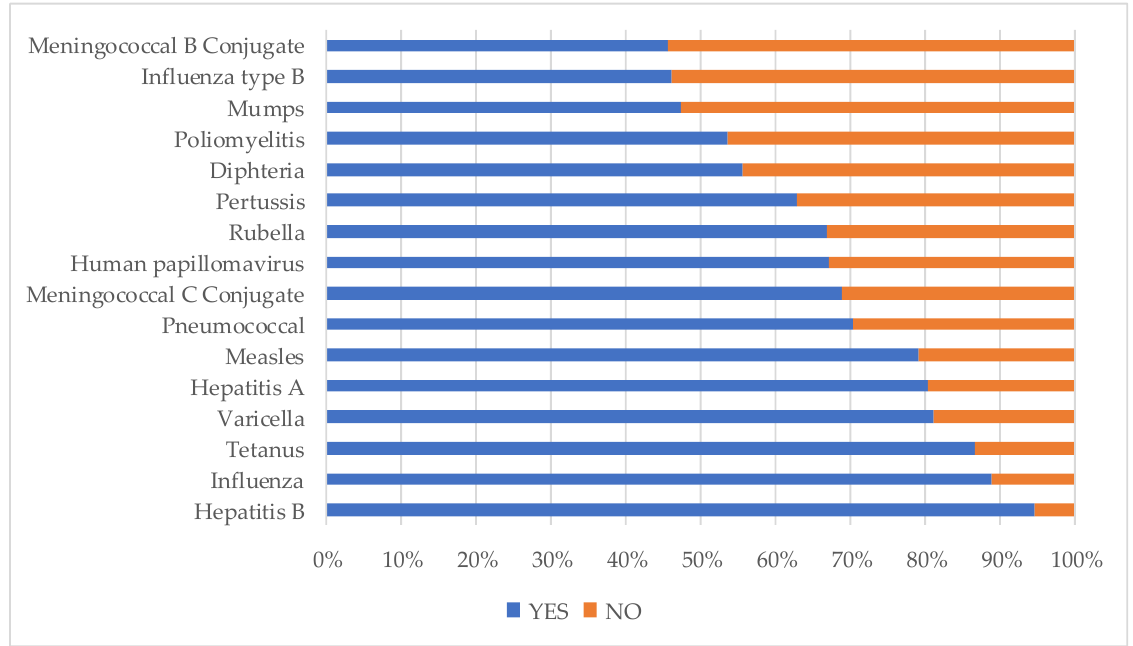
Figure 1. Knowledge about the vaccines that are necessary for health